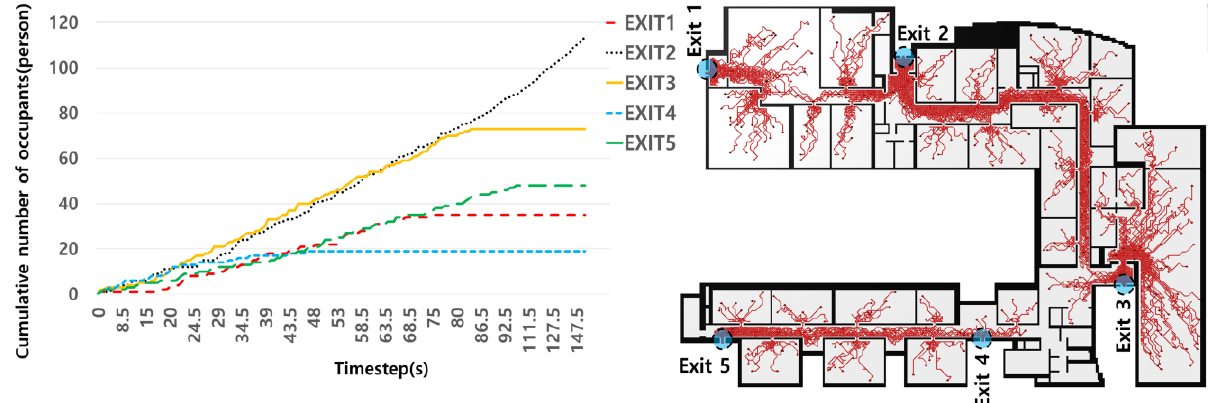
Figure 14. Situation 2: Evacuation when a fire initiated at location 1